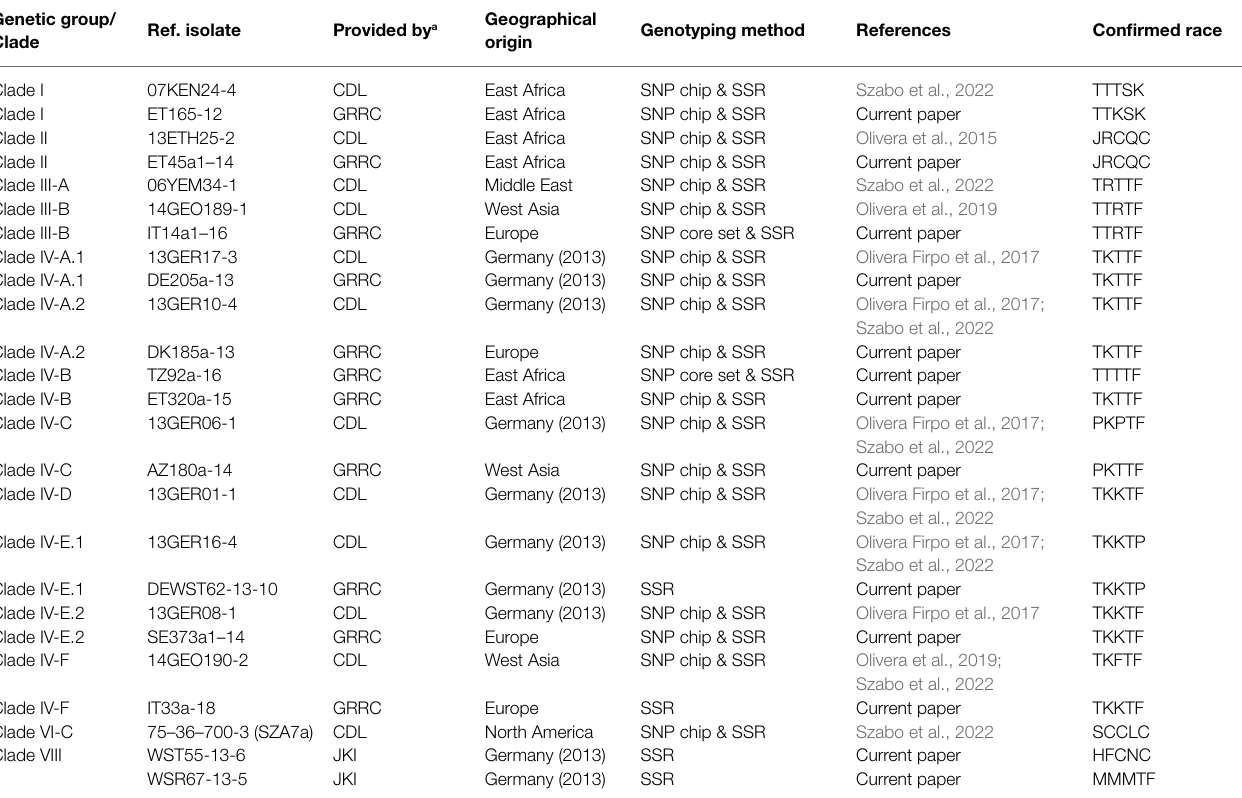
TABLE 2 | Reference isolates of diverse origin, including isolates from the outbreak in Germany in 2013 to facilitate alignment of race, SSR genotype and SNP genotype in Puccinia graminis f.sp. tritici. Genetic group/ Ref. Clade